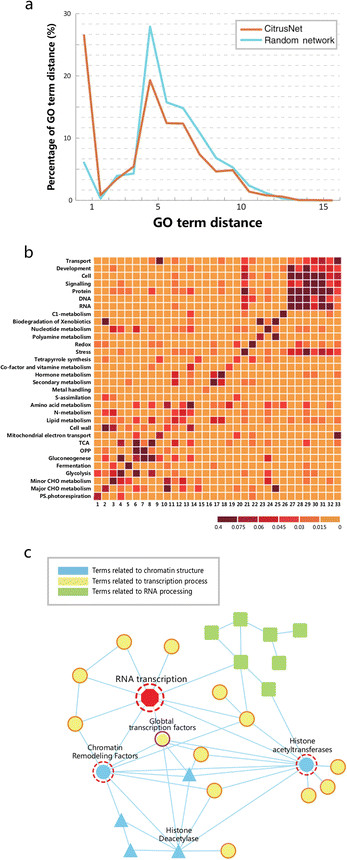
GO term and Mapman validation of CitrusNet. (a) Distance distribution of GO terms in CitrusNet and a random network. Orange line indicates CitrusNet prediction, and blue line represents the random network. (b) Heatmap of the correlation for different Mapman terms. Light yellow indicates that the two Mapman terms have relatively low correlation, and dark red indicates the two terms have relatively high correlation. (c) RNA transcription network based on Mapman annotations. Yellow nodes indicate terms related to transcription, blue nodes indicate terms related to chromatin structure, and grass green nodes indicate terms related to RNA processing.